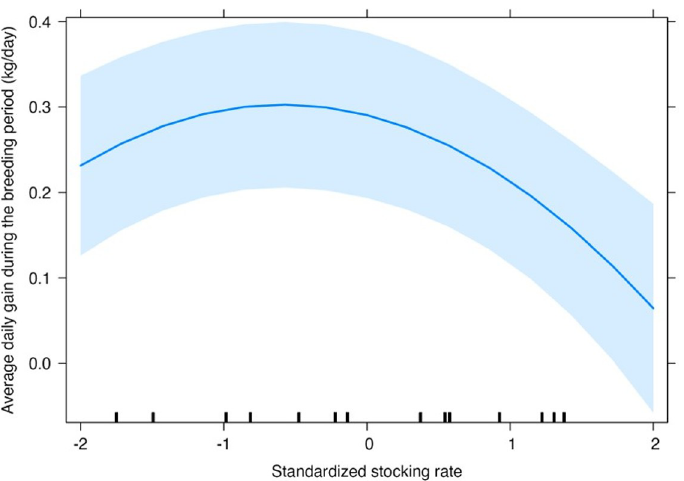
Fig 5. Average daily gain during the breeding season and stocking rate of heifers and primiparous cows. Shaded strip shows the 95% confidence band.